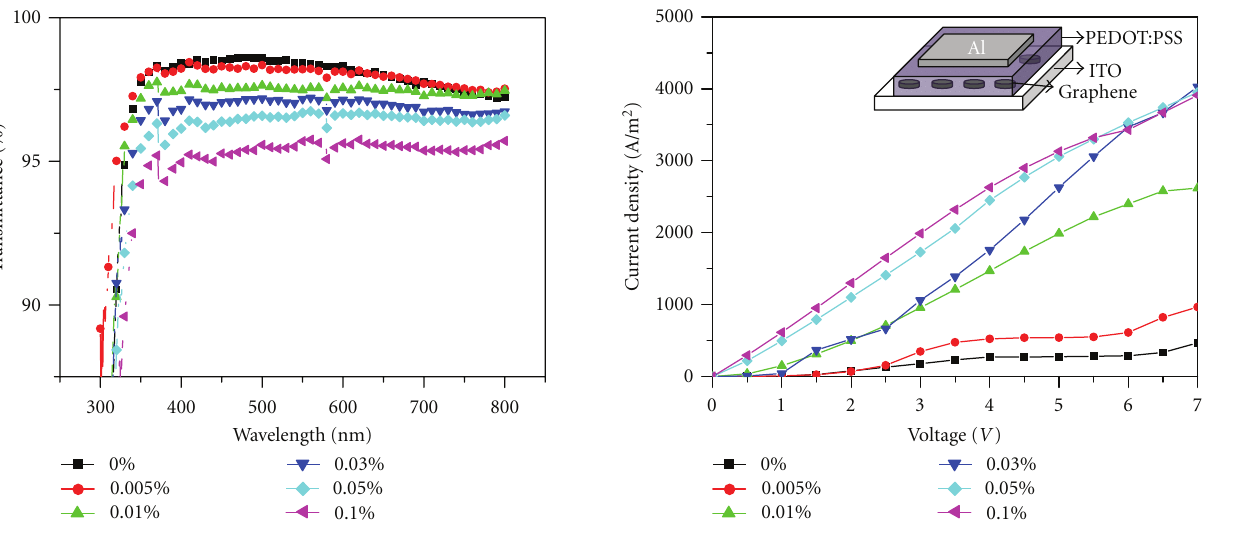
Figure 2: Measured curves showing transmittance as a function wavelength for PEDOT:PSS/graphene layers with various graphene concentrations.